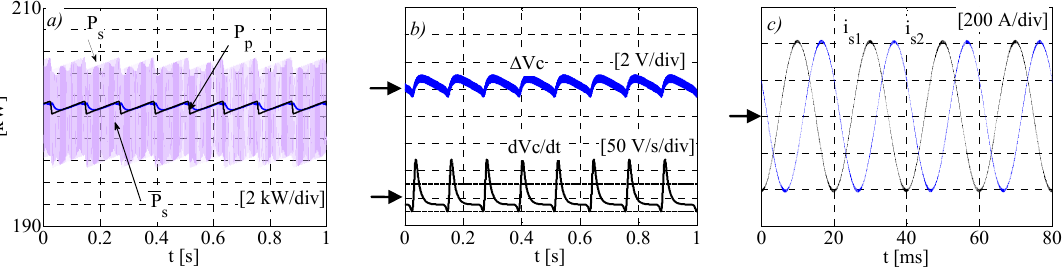
Figure 8. Main electrical quantities during steady state condition at 1000 W/m 2 radiation value: ( a ) grid and PV power; ( b ) capacitor voltage and time derivative; ( c ) line currents. The capacitor voltage variation with respect to v MPP ( ∆ v c = v c − v MPP ) is shown in Figure 8b,